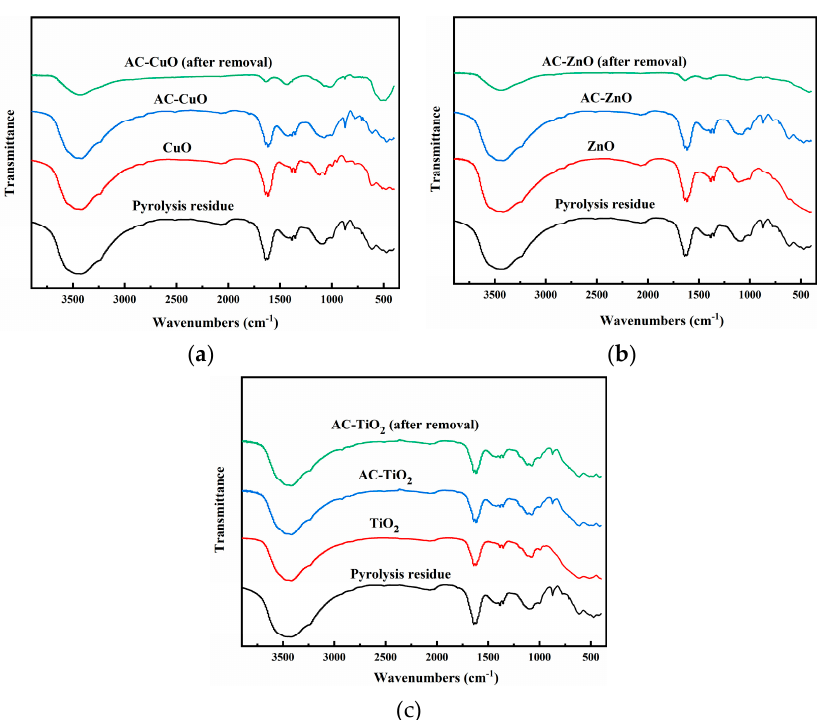
Figure 7. FT-IR images of residue carrier; ( a ) AC-CuO; ( b ) AC-ZnO; and ( c ) AC-TiO 2 . XPS